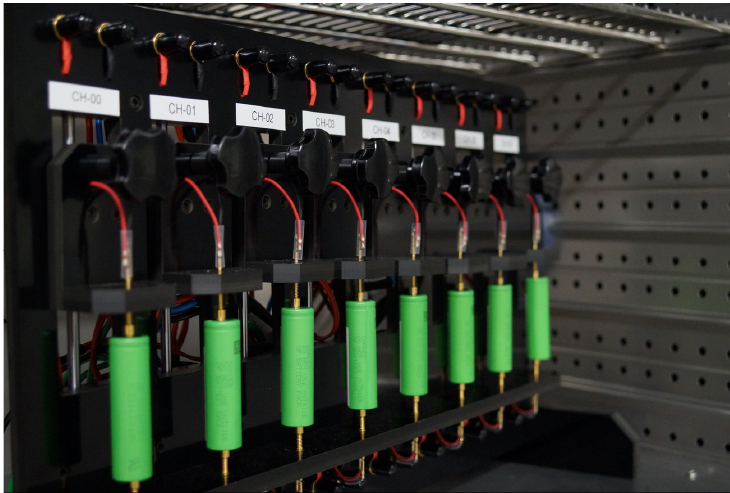
Figure 2. Cylindrical lithium-ion cells connected via cell holder.